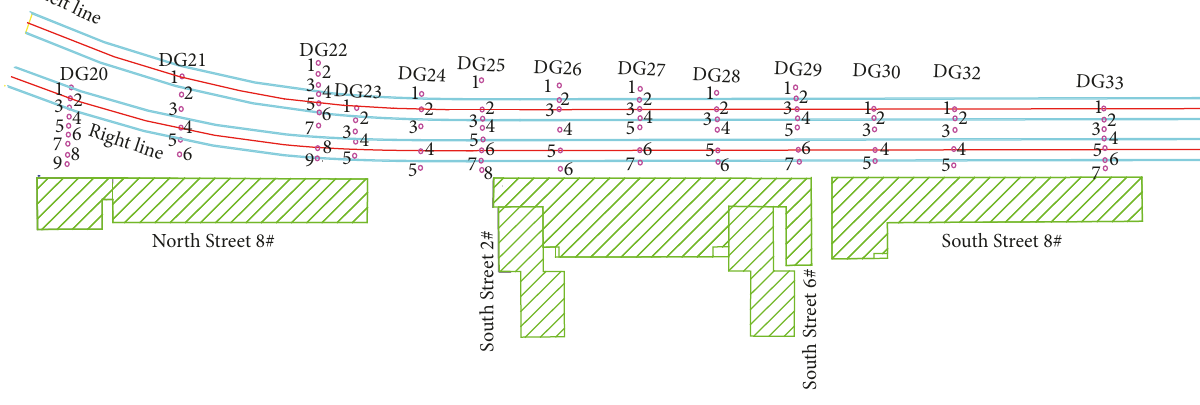
Figure 8: Plan of tunnel line, buildings, and layout of surveying points.